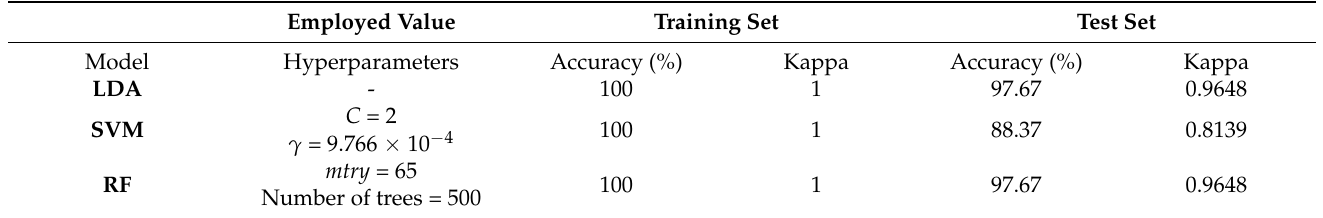
Table 1. Accuracy and kappa results for the different classification algorithms applied on the complete spectroscopic data matrix (D 184 × 4190